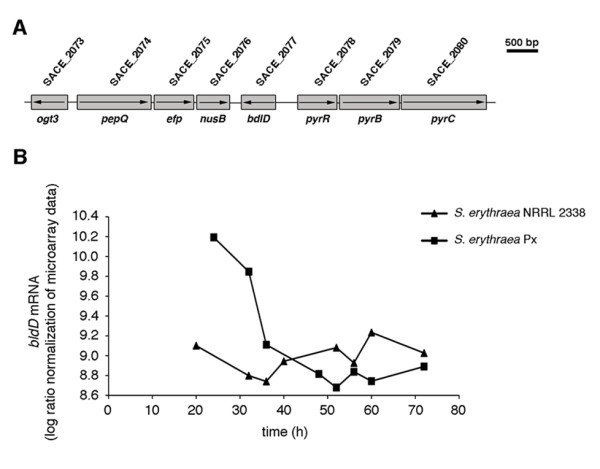
Expression of bldD during growth of S. erythraea NRRL 2338 and S. erythraea Px. A) Genetic map of the chromosomal region spanning the pepQ-efp-nusB and bldD genes. B) bldD mRNA levels are expressed as average of log ratio normalized microarray duplicate data (RMA). bldD expression values from S. erythraea NRRL 2338 and S. erythraea Px do not vary more than 1.58% and 2.61%, respectively, on the average.